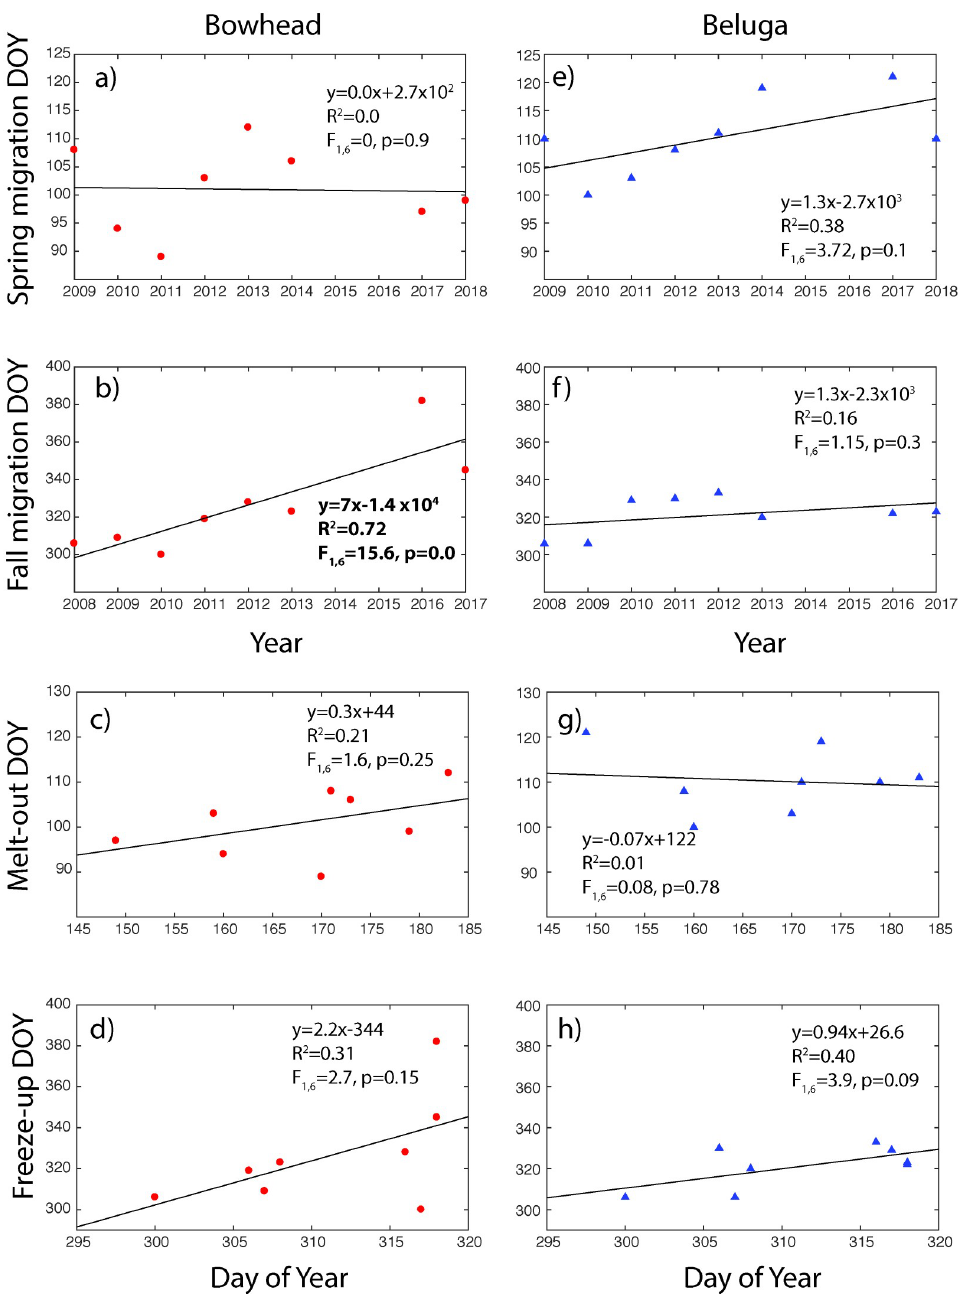
Fig 5. Linear relationship of acoustically detected migration passage day of year (DOY) by year and by melt-out and freeze-up DOY from 2008–2018. a) bowhead whale migration DOY in spring; b) bowhead whale migration DOY in fall. DOY over 365 indicates passage date in January 2017; c) bowhead whale migration and spring melt-out DOY; d) bowhead whale migration and fall freeze up DOY; e) beluga whale migration DOY in spring; f) beluga whale migration DOY in fall; g) beluga whale migration and spring melt out DOY; h) beluga whale migration and fall freeze up DOY. Trend, fit (r 2 ), and F-statistics of acoustic migration DOY by year and sea ice thaw/freeze up DOY over time are shown on each plot. Significant statistical relationships ( p < 0.05) are shown in bold type on the figures.